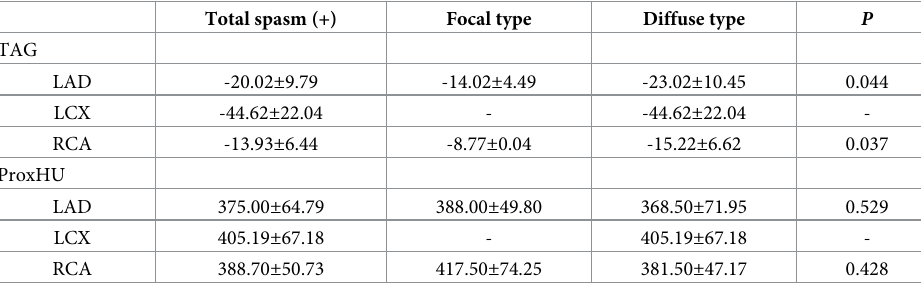
Table 4. Subgroup analysis of spasm (+) vessels on baseline